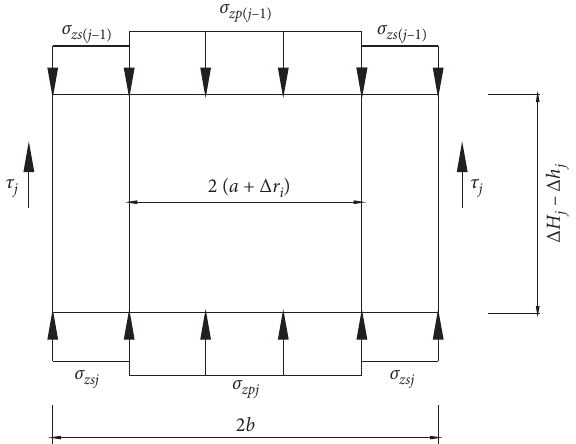
Figure 5: Stress analysis of the j- th pile-soil microelement in the unreinforced